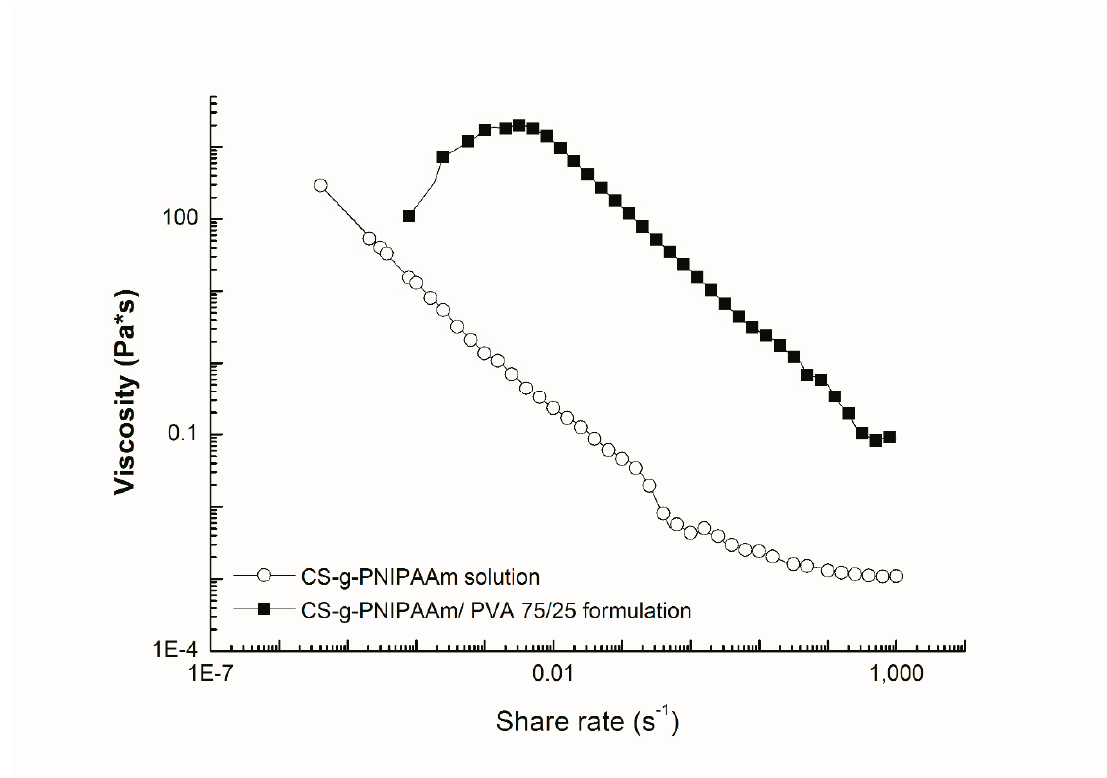
Figure 1. Flow behavior of the formulations prepared from grafted copolymer, with and without PVA.